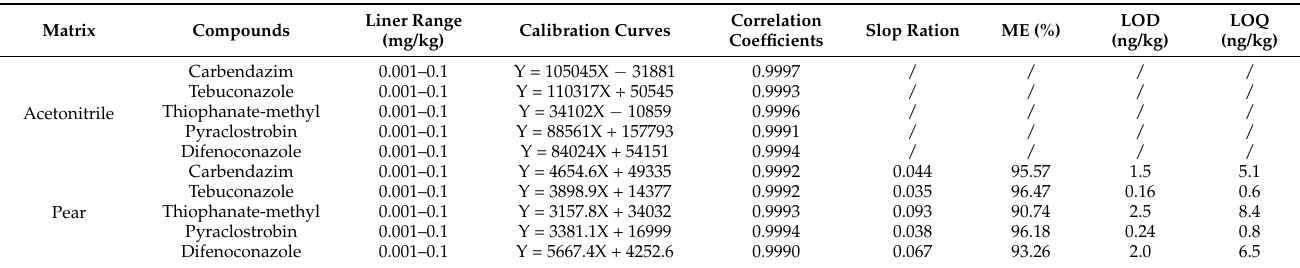
Table 1. Linear ranges, matrix effects, limits of detection (LODs), and limits of quantitation (LOQs) of the five